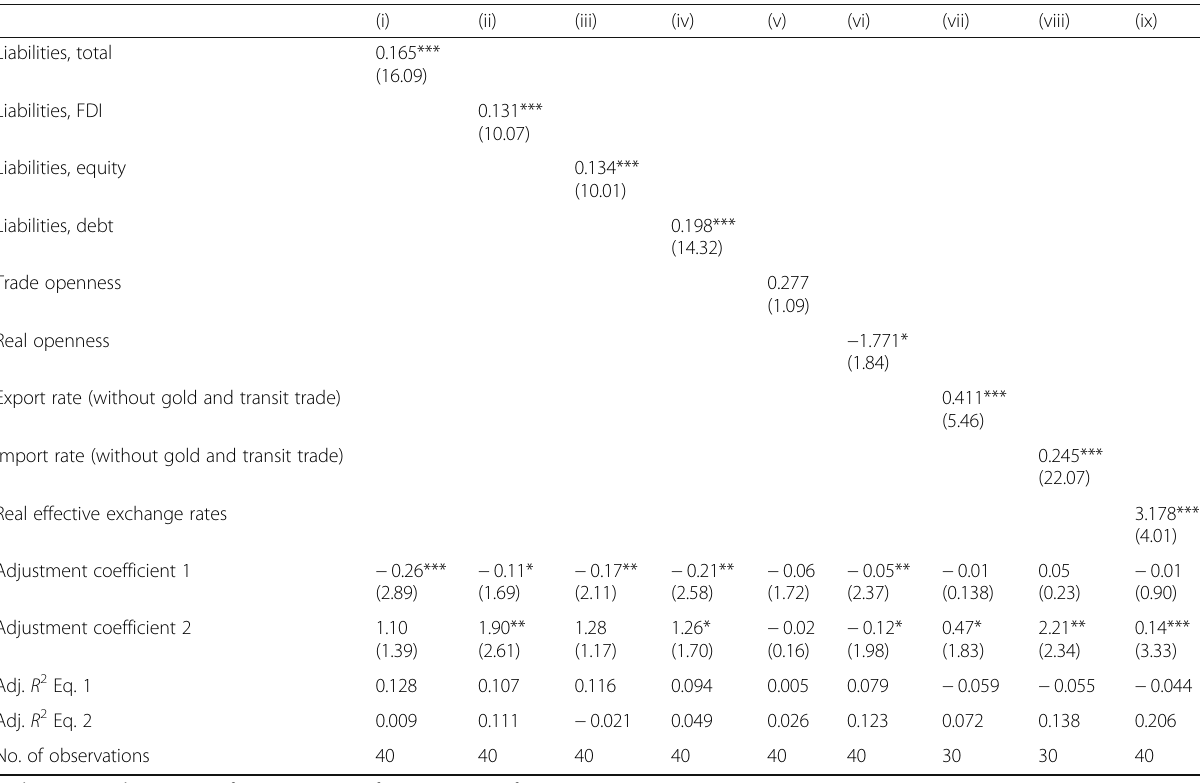
Table 2 Relationship between selected openness measures and labor productivity (long-run coefficient ( β ) and adjustment coefficients ( α 1 , α 2